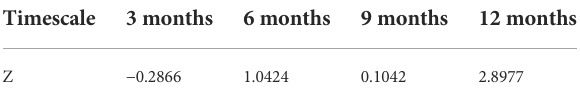
TABLE 1 Trend changes in the propagation time from meteorological drought to hydrological drought in the Weihe River Basin at different timescales.